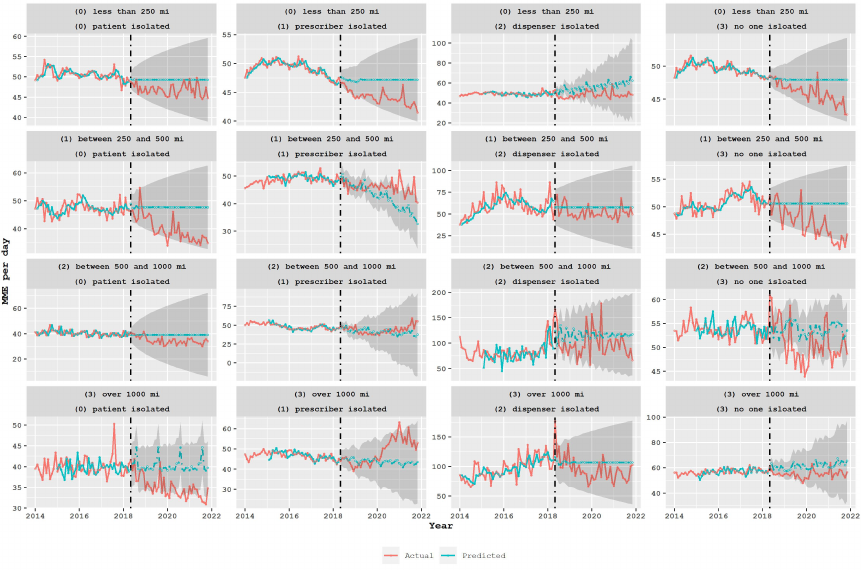
Figure 6. Average daily MME for opioid prescriptions in the state of South Carolina over a period of time (measured in months) for different proposed classes. The broken vertical line indicates the legislative intervention that was enacted in May 2018. The blue line represents the fit of the mathematical model.